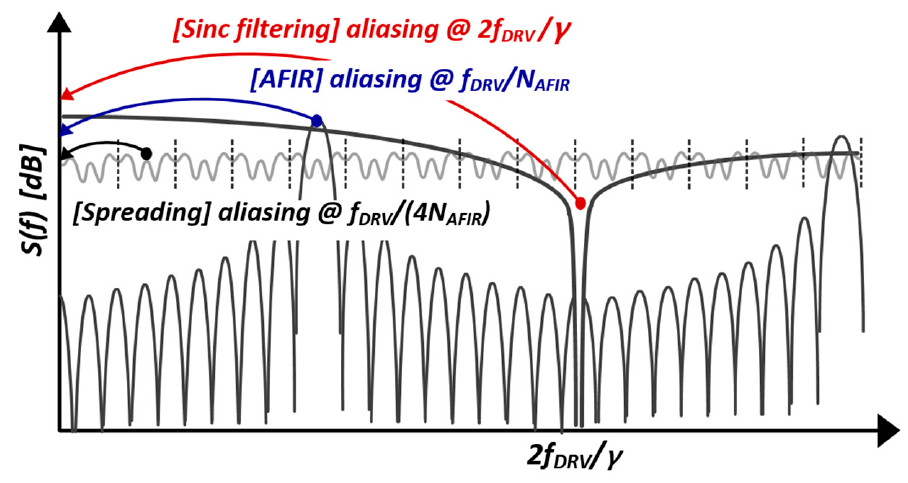
Figure 12. Overall cascaded transfer function of AFE.